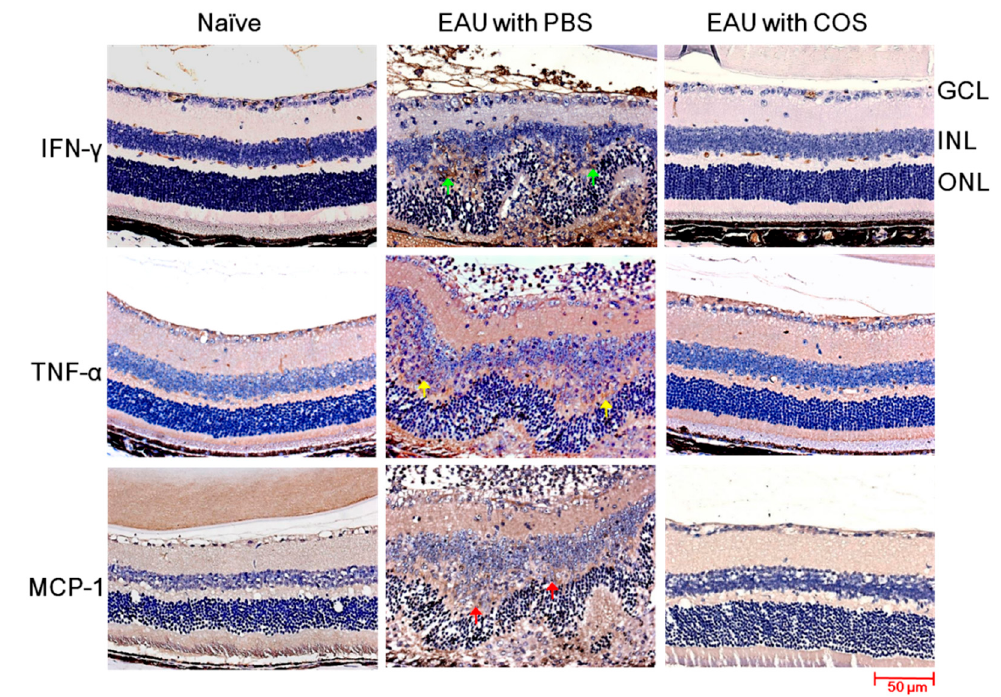
Figure 3. Immunohistochemical examination of inflammatory mediators in the mouse retinas. Eyes of mice without EAU induction and treatment (naïve) or with EAU induction and treated with PBS or COS (20 mg / kg) were examined by staining for the indicated inflammatory mediators. The retinal portion is shown. The green, yellow, and red arrows indicate the cells positive for IFN- γ , TNF- α , and MCP-1, respectively. Images are representative of more than four samples per group from two independent experiments. GCL, ganglion cell layer; INL, inner nuclear layer; ONL, outer nuclear layer.